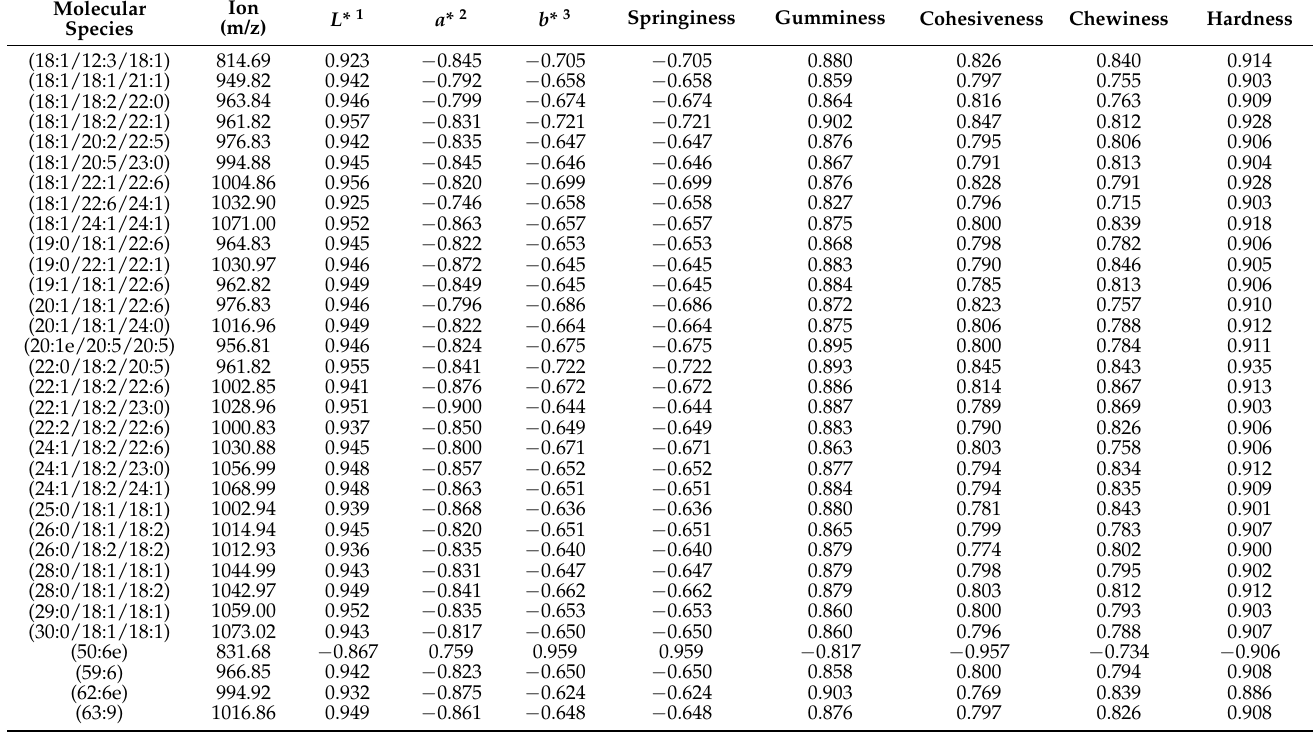
low-temperature storage. The X -axis represents pathway enrichment, and the Y -axis represents the pathway influence. Large sizes and dark colors represent the major pathway enrichment and high pathway impact values,